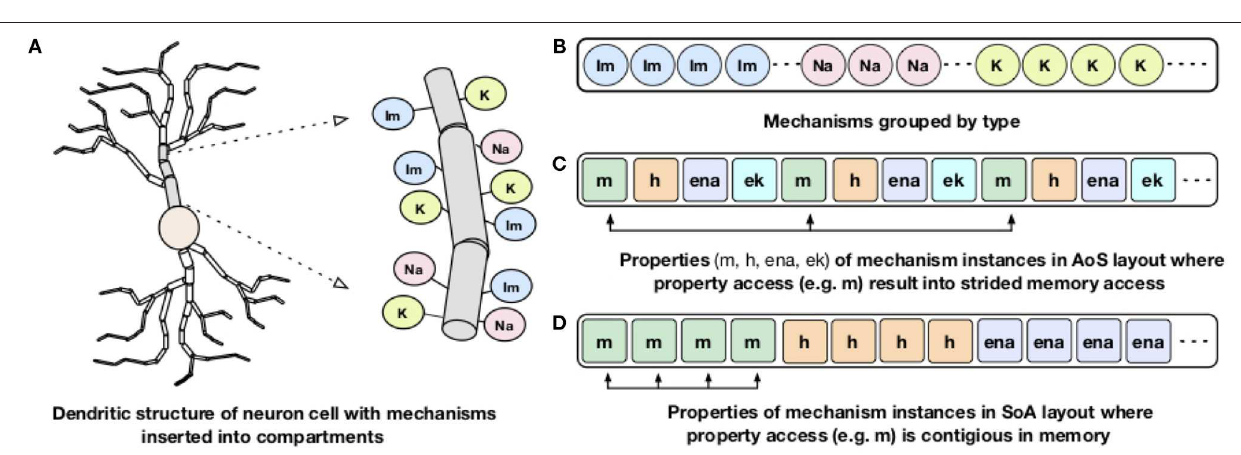
FIGURE 3 | Dendritic structure and memory layout representation of a neuron: A schematic representation of dendritic structure of a neuron with different mechanisms inserted into the compartment is shown on the left (A) . On the right: (B) shows how NEURON and CoreNEURON groups the mechanism instances of the same type; (C) shows how NEURON stores properties of individual mechanism in the AoS layout; (D) shows the new SoA layout in CoreNEURON for storing mechanism